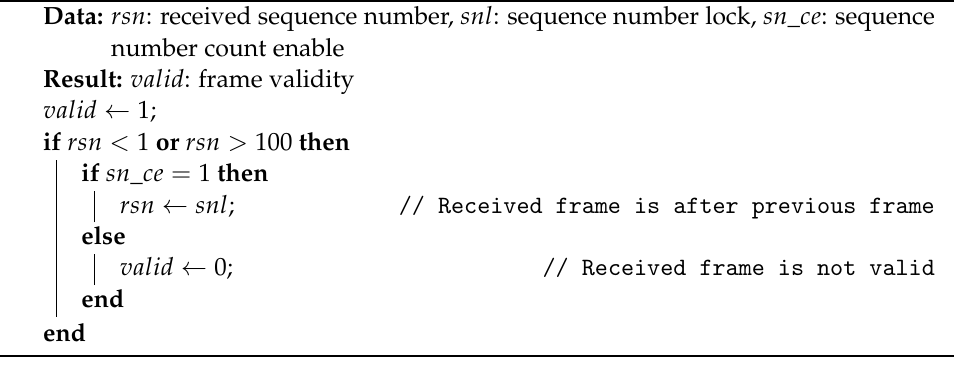
Algorithm A2: Frame validity and out of bounds check